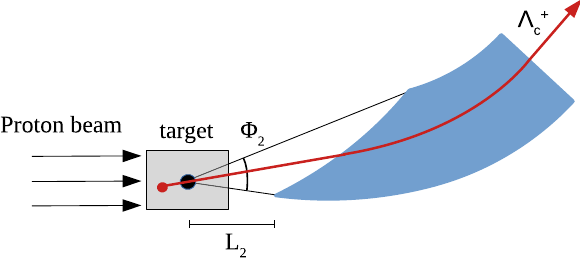
Fig. 1 Sketch of the single-lens scheme. The proton beamlet arrives directly to the target, where the (cid:2) + c are produced (red dot) and a small fraction ( ∼ 10 − 3 ) of them are subsequently channeled in the crystal